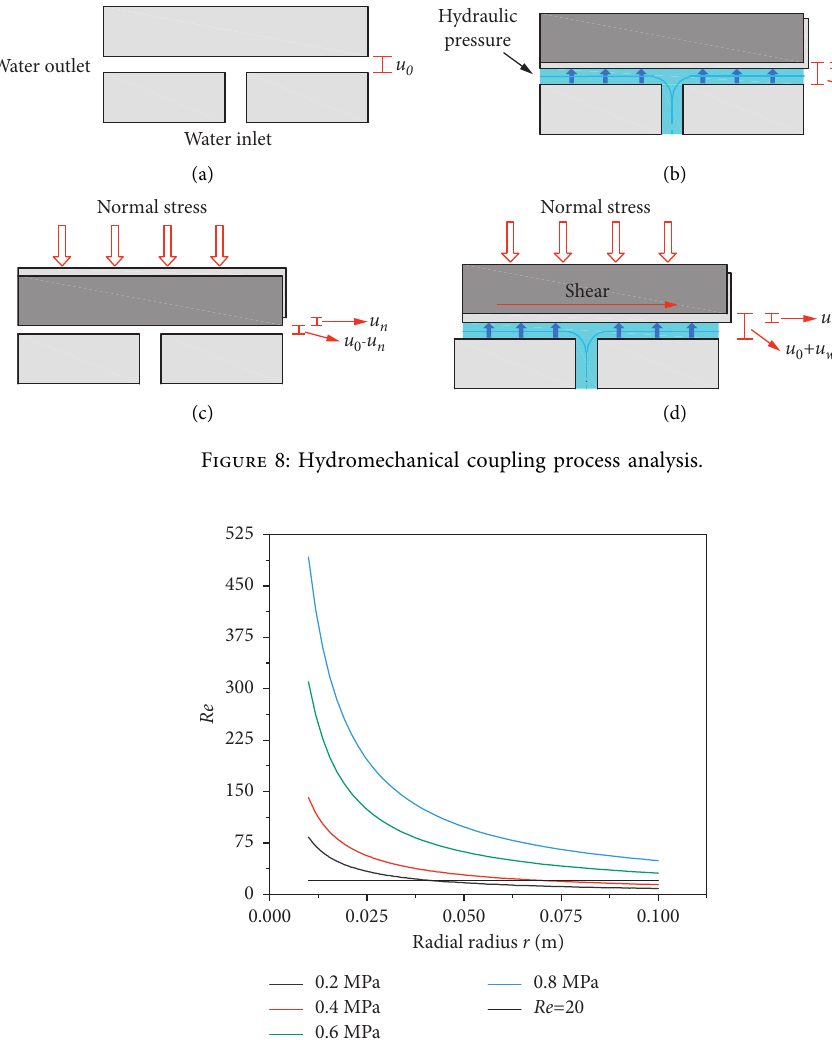
Figure 9: The variation curve of Reynolds number along radial distance under different hydraulic pressure